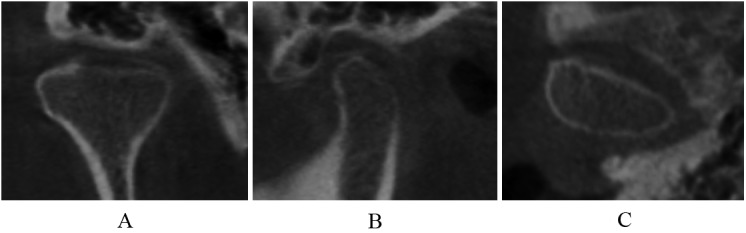
Surface erosion in coronal (A), sagittal (B), and axial (C) images.